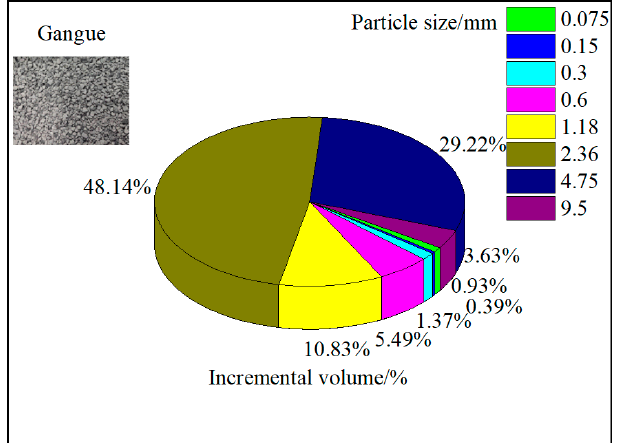
Figure 1. Particle size distribution of gangue.